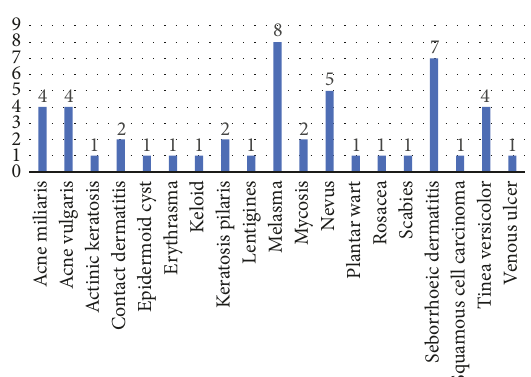
Figure 3: Diagnoses of the consultations rated as